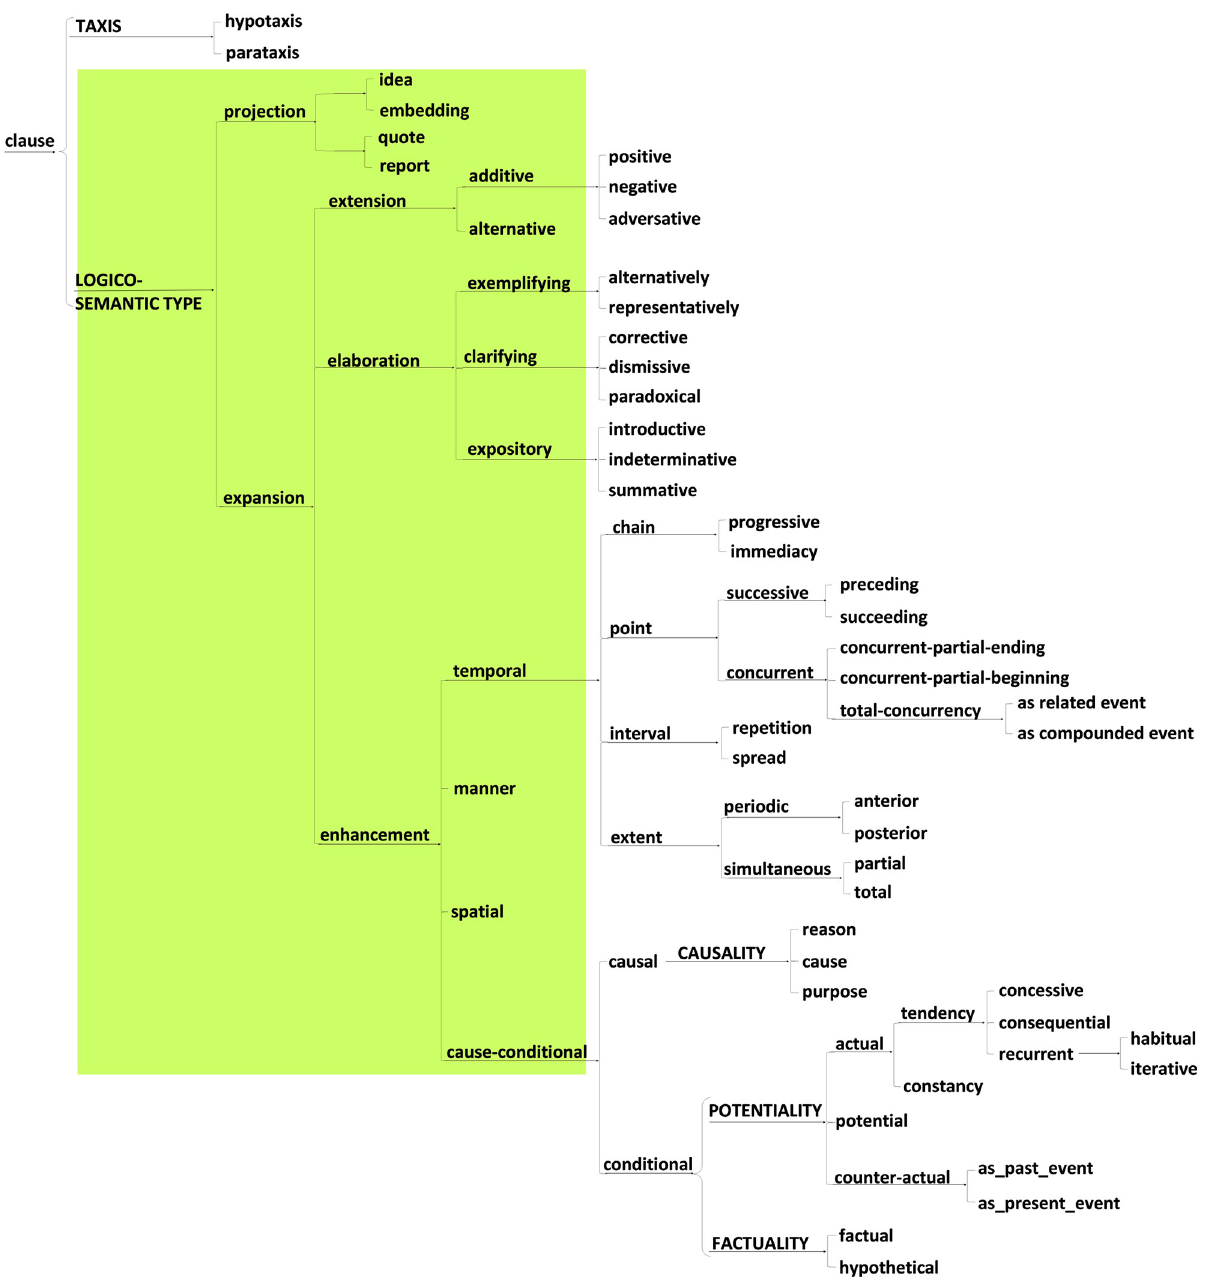
Fig 10. LOGICAL systems in Japanese from the ideational metafunction. This was constructed by transfer comparison following Halliday [41]. The current annotation scheme incorporated the items in the green-colored portions.